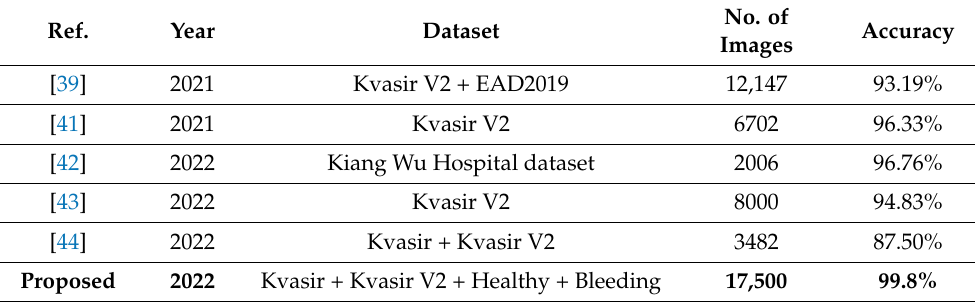
Table 5. Comparison of the proposed model with existing techniques.